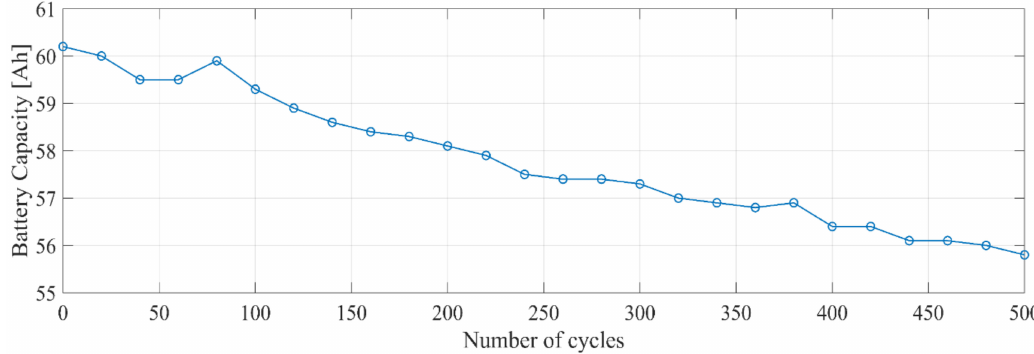
Figure 3. Battery capacity decrease during the aging test.